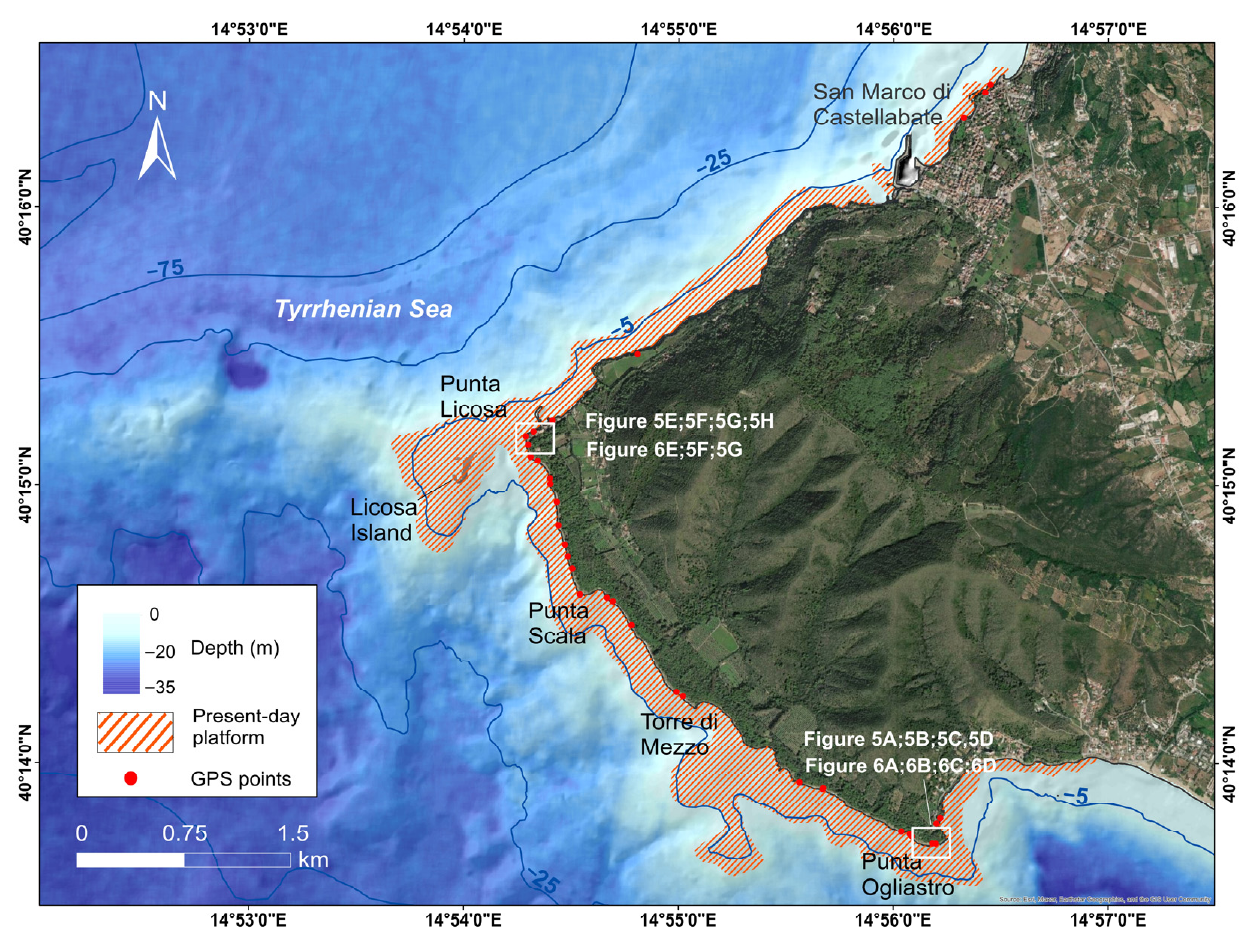
Figure 4. Distribution of the present-day platform along the Punta Licosa promontory. The DTM of the submerged sector is derived from satellite image analysis.